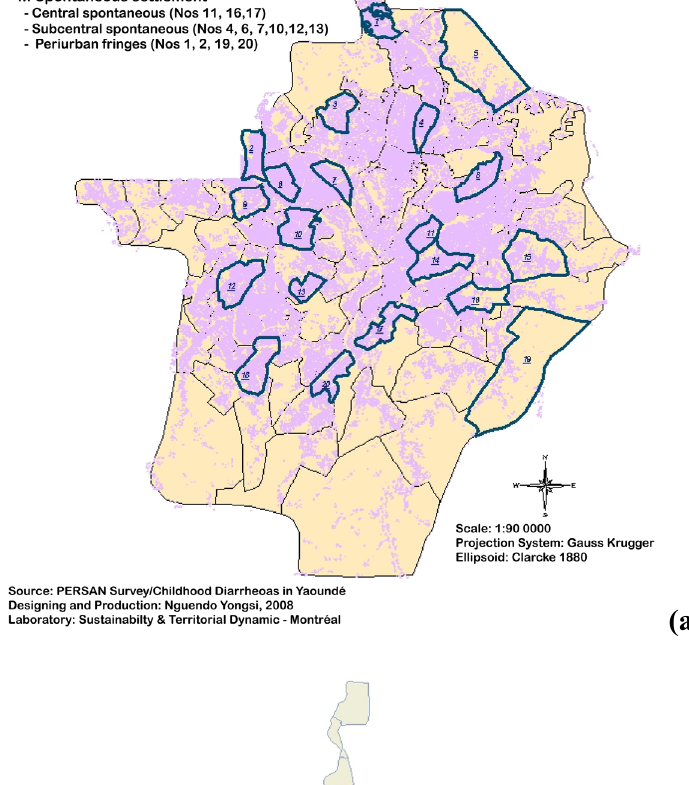
Figure 2. (a) Selected neighbourhoods. (b) Surveyed households with < 5 years Children.